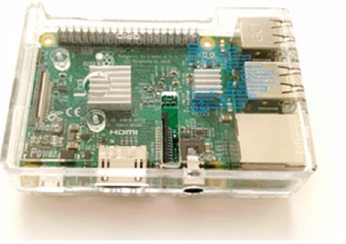
Figure 3. Selected node: Raspberry Pi 3.